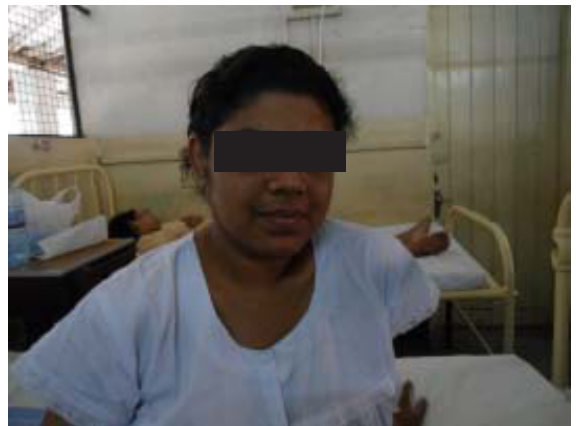
Figure 1. Patient showing round, plethoric “moon” face and pigmentation.